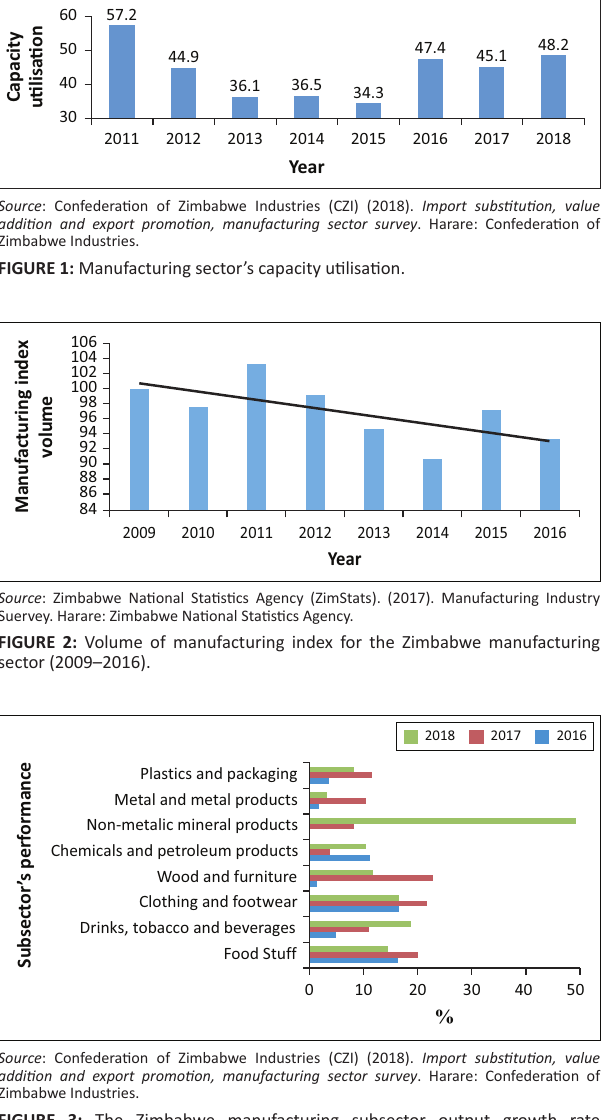
FIGURE 3: The Zimbabwe manufacturing subsector output growth rate (percentage), 2016–2018.